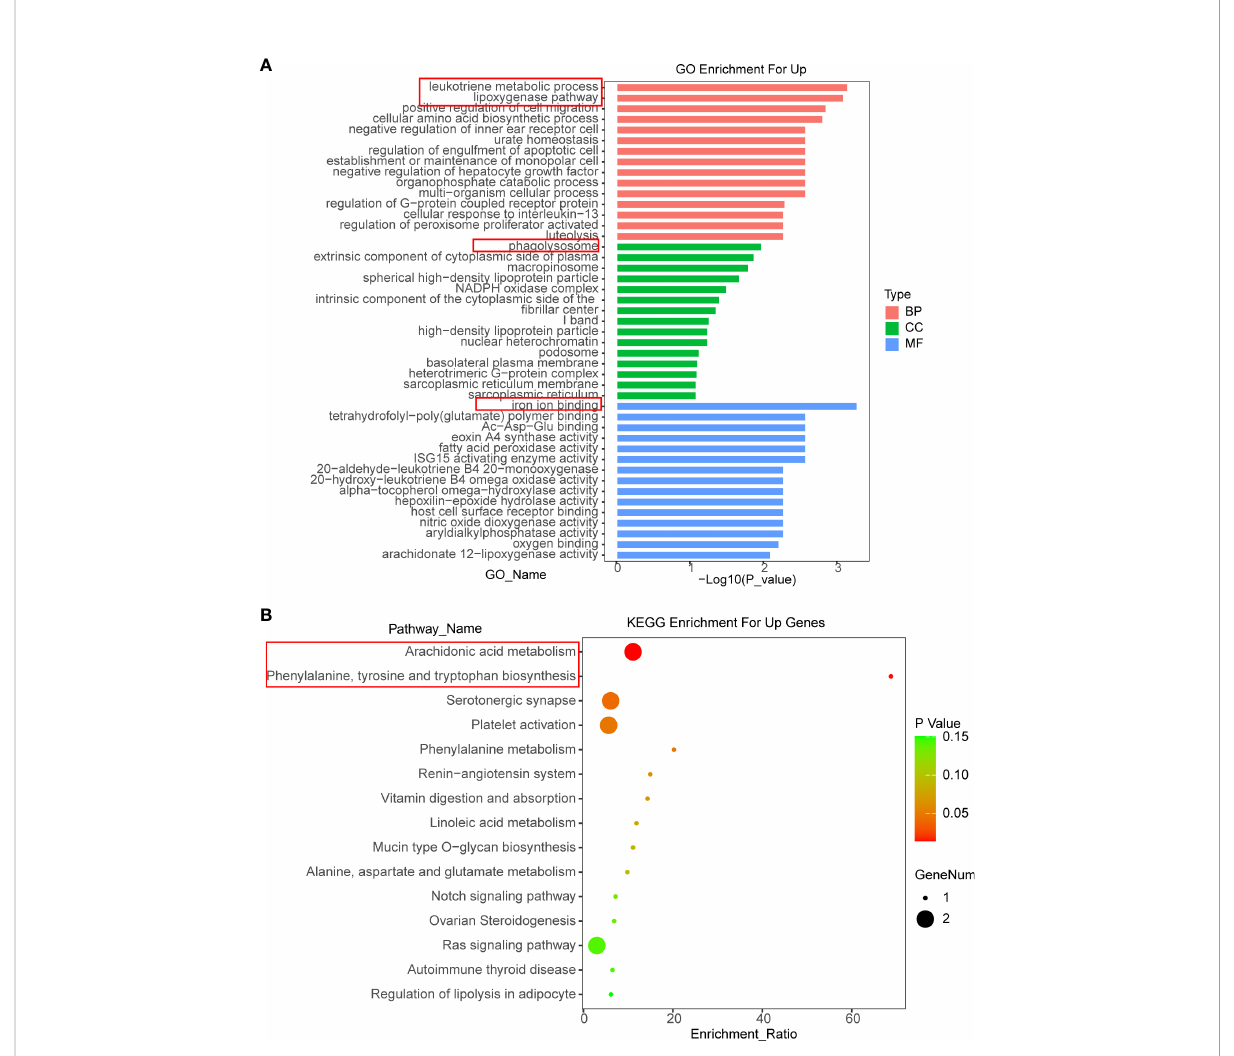
FIGURE 6 The functional annotation for the DEGs based on the DAVID. (A, B) The differently expressed genes of HepG2 cells related to biological process (BP), cellular component (CC), molecular function (MF), and KEGG enrichment analysis were displayed separately. BP, biological process; CC, cellular component; MF, molecular